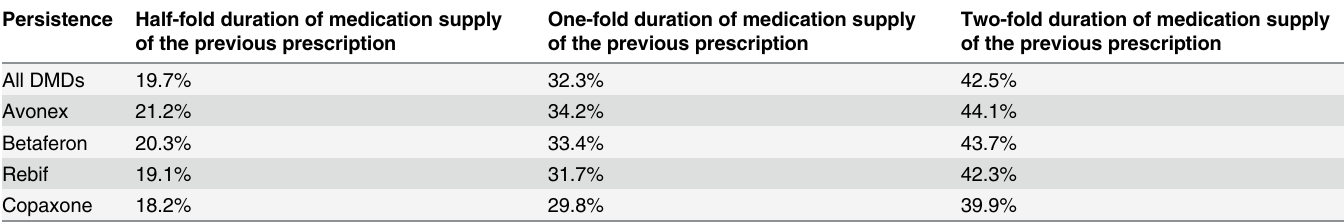
Table 3. Sensitivity analysis (S2): Proportion of profiles of persistent patients for three different definitions for the tolerable gap in medication profiles. Persistence Half-fold duration of medication supply One-fold duration of medication supply Two-fold duration of medication supply of the previous prescription of the previous prescription of the previous